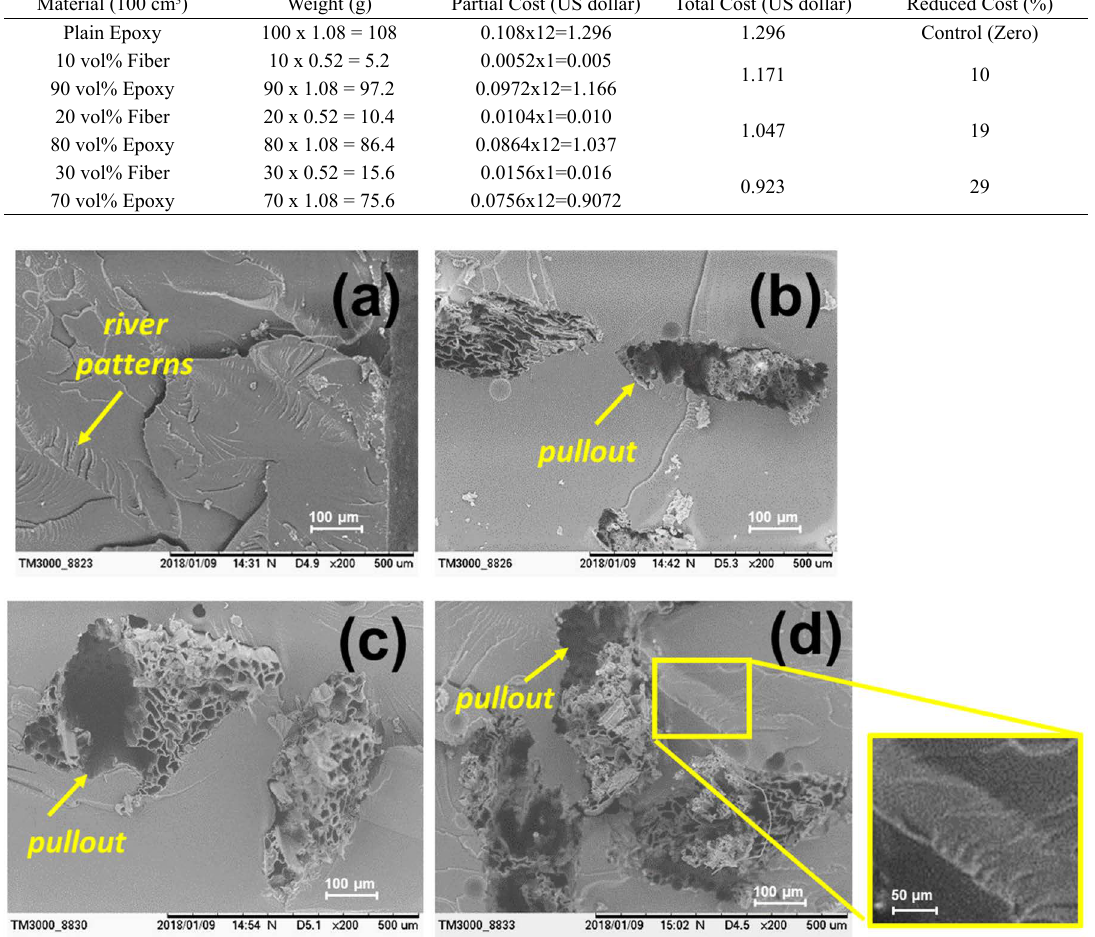
Figure 8. SEM fractographs of typical tensile ruptured specimens: (a) plain epoxy; (b) 10 vol% guaruman fiber; (c) 20 vol% guaruman fiber; and (d) 30 vol% guaruman fiber reinforced epoxy